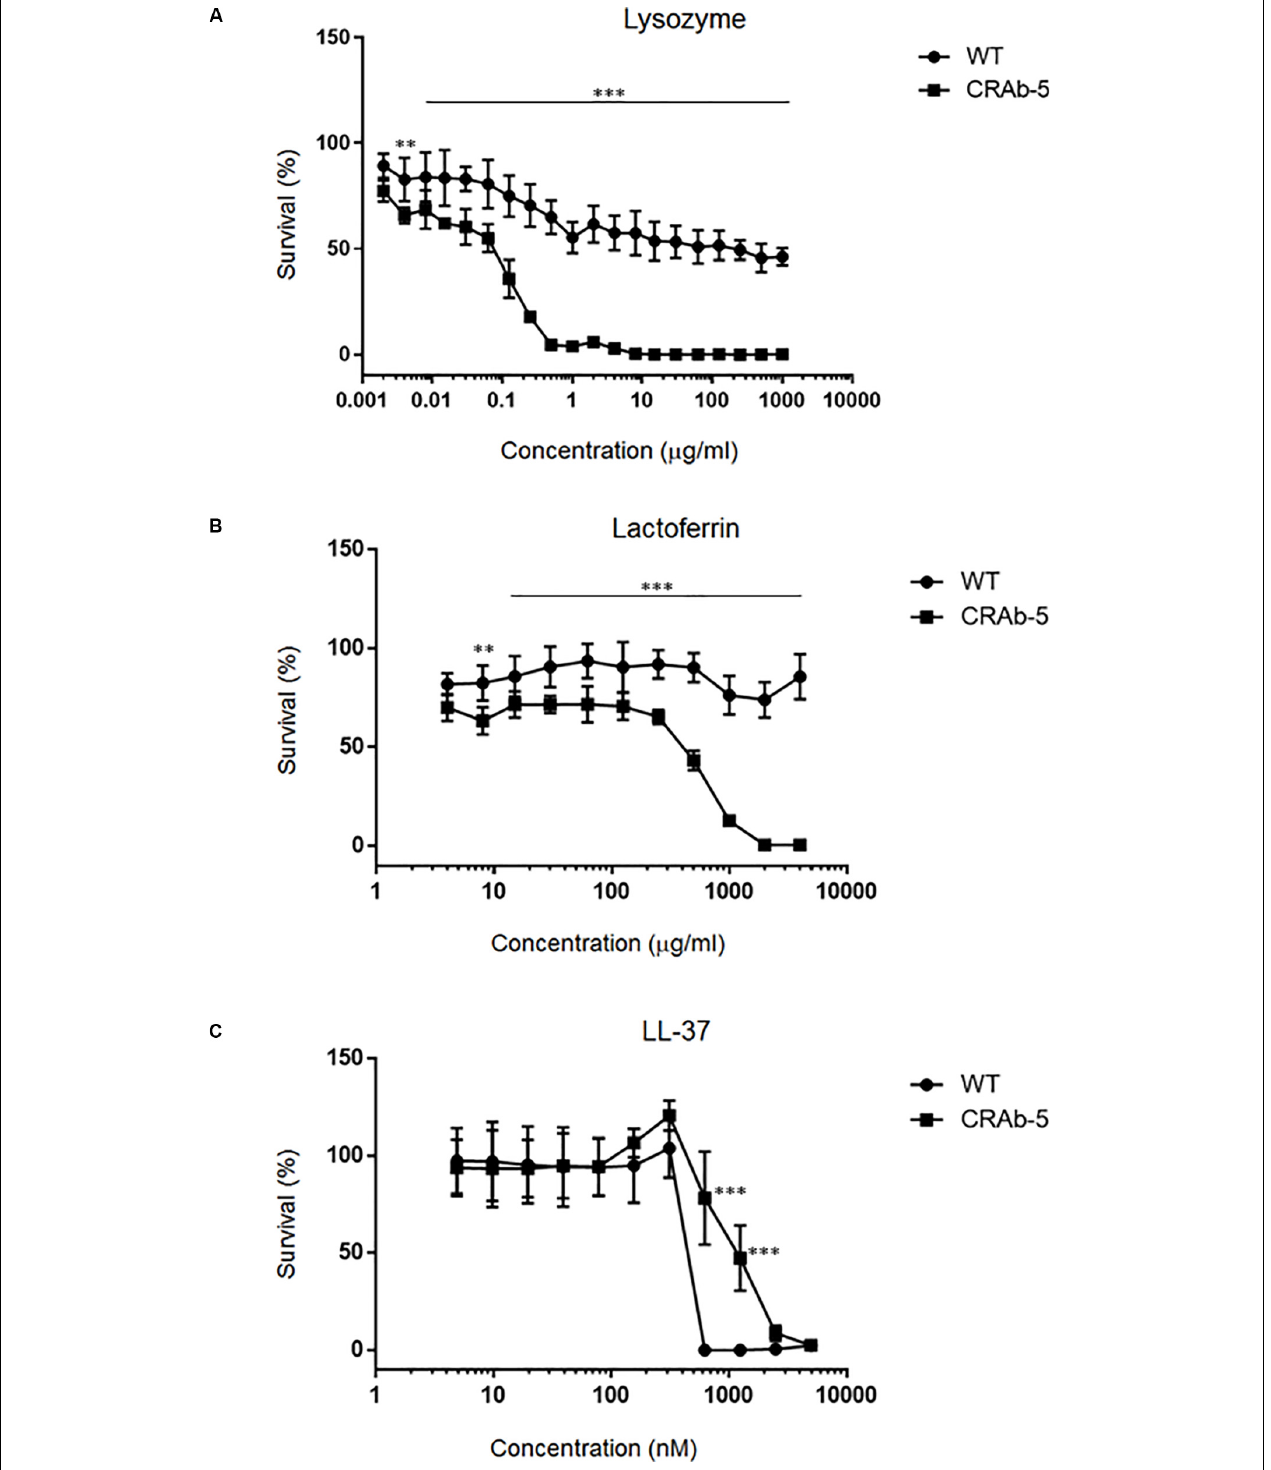
FIGURE 5 | Dose–response curves of bactericidal ability of various biomolecules against lipopolysaccharide-deficient Acinetobacter baumannii strains. A twofold dilution series of (A) lysozyme (maximum concentration 1000 µ g/ml), (B) lactoferrin (maximum concentration 4000 µ g/ml), or (C) LL-37 (maximum concentration 5000 nM) was prepared and the viabilities of the ATCC 19606 (wild type) or colistin-resistant A. baumannii strain (CRAb-5) were assessed. Survival rates were calculated as percentages of the uninhibited, pure bacterial culture. Data are means ± SD; n = 3 per group. ∗∗∗ P < 0.001, ∗∗ P < 0.01.